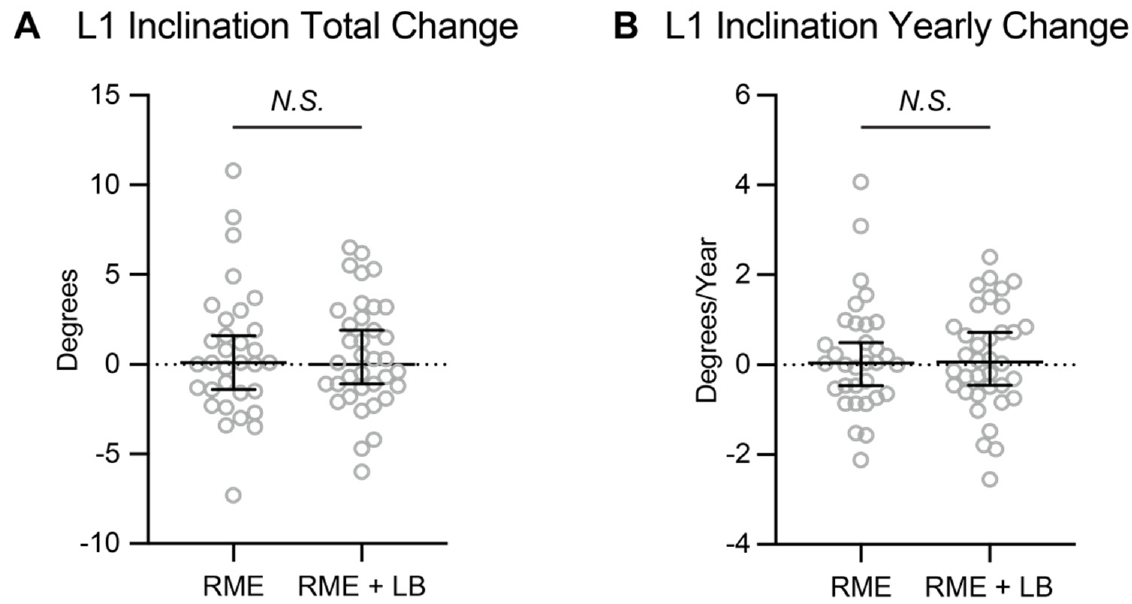
Figure 2. The ( A ) total change and ( B ) yearly change of the mandibular central incisors’ inclination. The data are presented as raw data overlapped with Median ± 95% confidence interval. RME: rapid maxillary expansion; LB: lip bumper; N.S. : not significant.